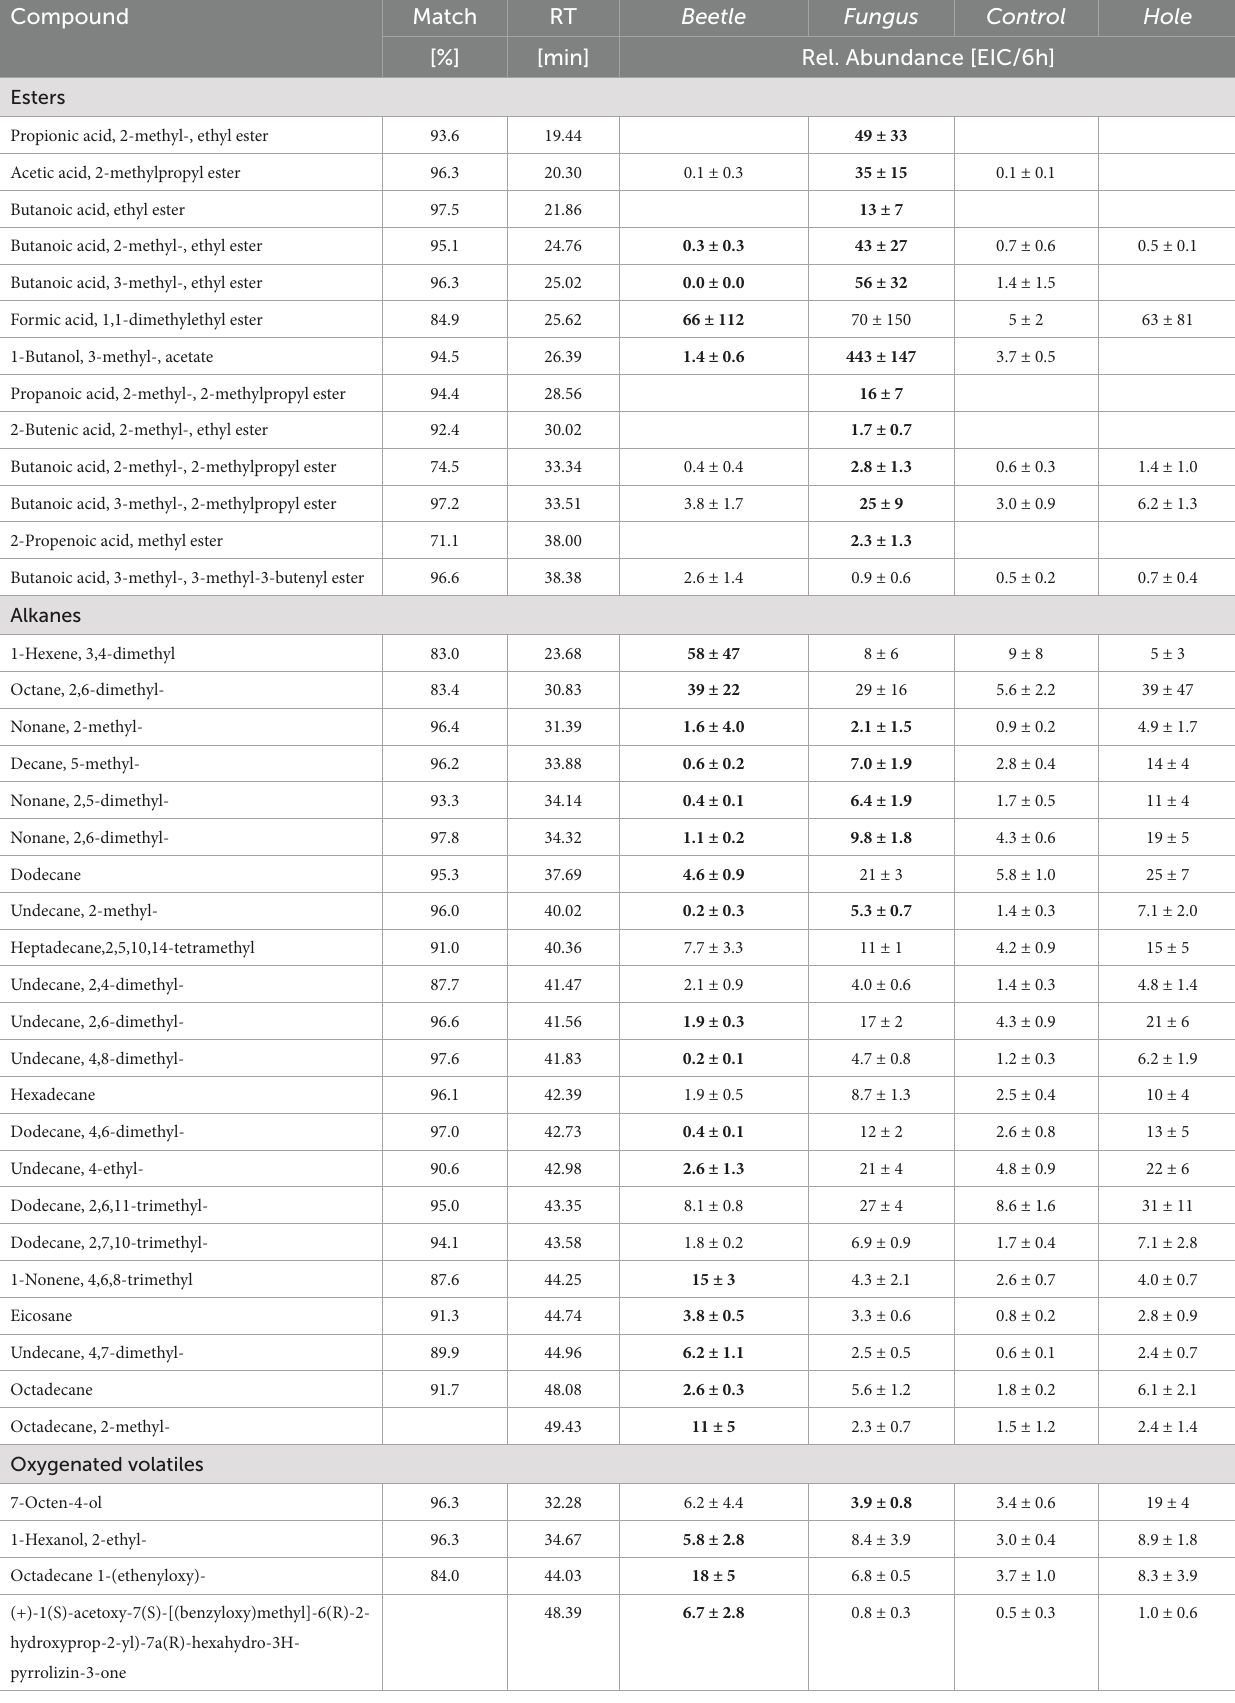
TABLE 2 Volatile compounds emitted from beech bolts infested by X. germanus (“beetle”) or infected by A. grosmanniae (“fungus”). Compound Match RT Beetle Fungus Control